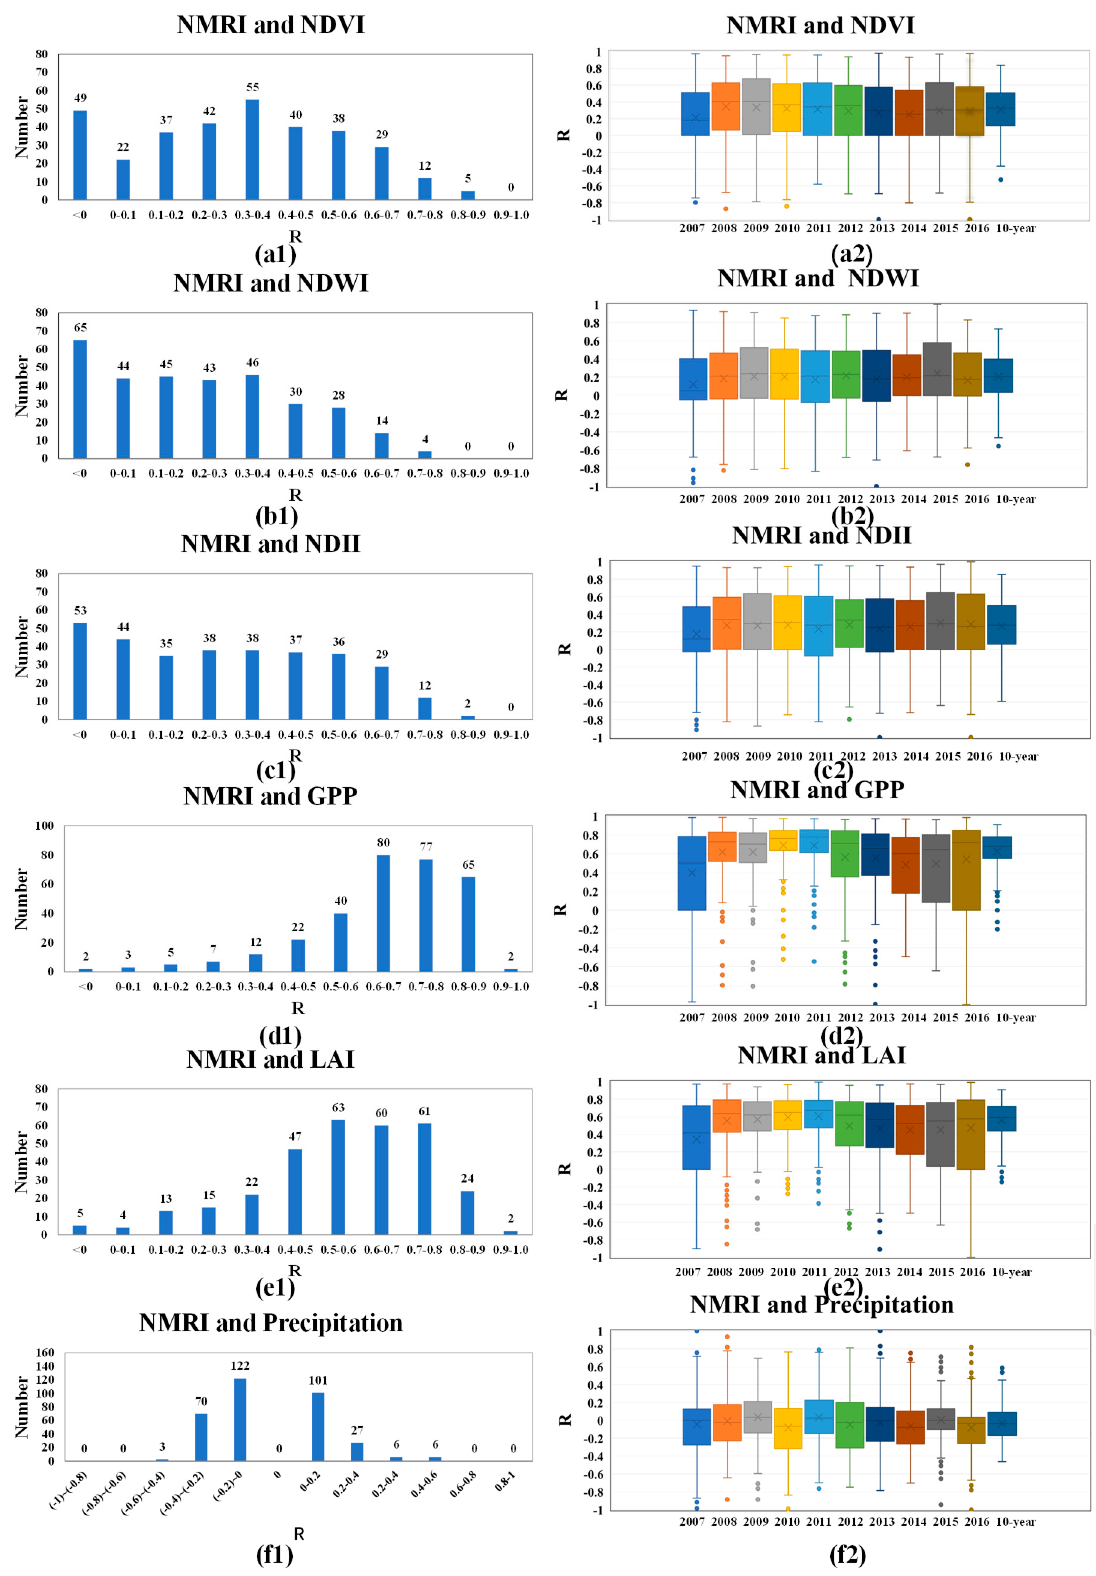
Figure 5. The bar charts and box charts of the correlation coefficients (R) between the six indices and NMRI: ( a1 – f1 ) bar charts of the correlation coefficients between the indices and NMRI in the different regions during the 10 years; ( a2 – f2 ) statistical distribution box charts of the correlation coefficients of each year and the total of the 10 years from 2007 to 2016.